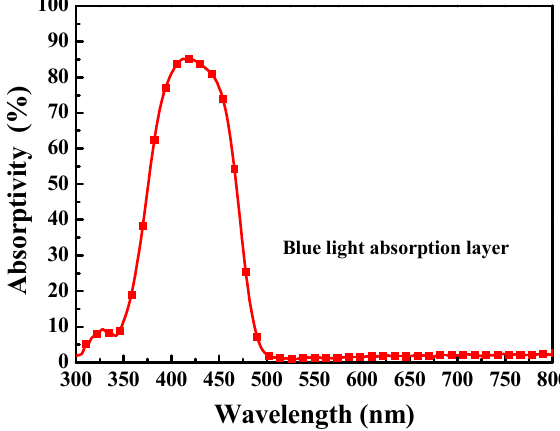
Figure 7. The absorptivity spectrum of the blue light absorption layer.